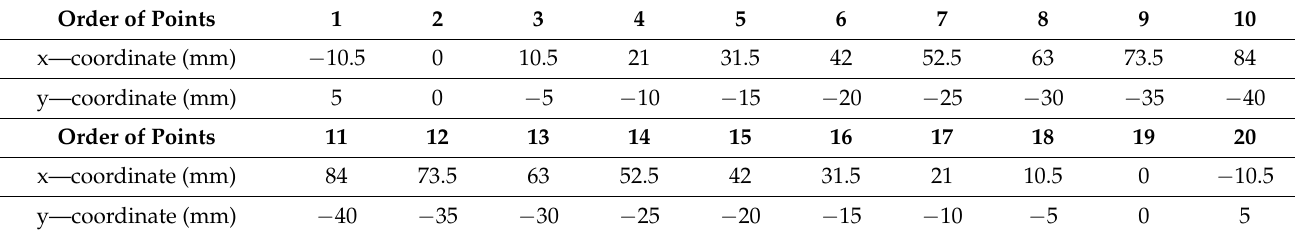
Table 1. Coordinates of precision